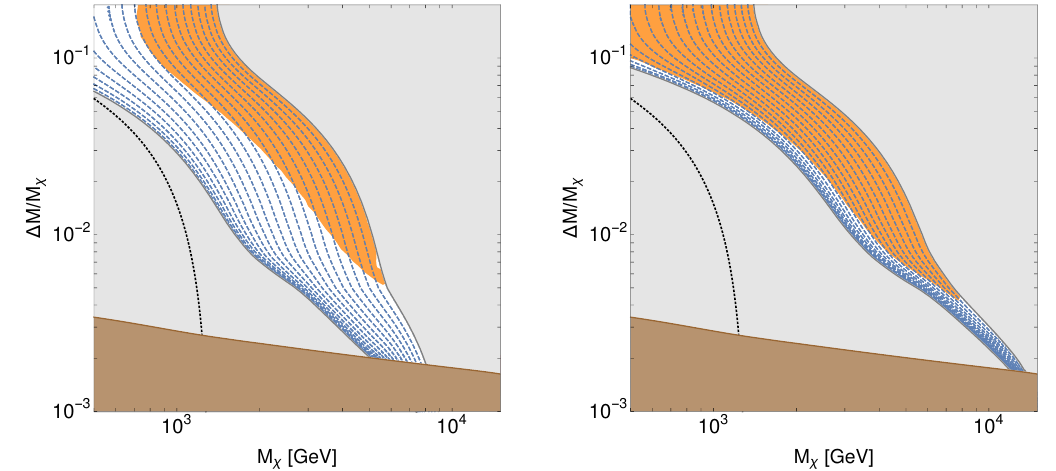
Figure 6 . Same as (cid:12)gure 5 for DM coupling to top quarks. Note that the coupling y preferred by thermal DM is the same as in (cid:12)gure 5 since the quark mass (Higgs Yukawa coupling) does not have an appreciable e(cid:11)ect on the relic density in the part of parameter space shown